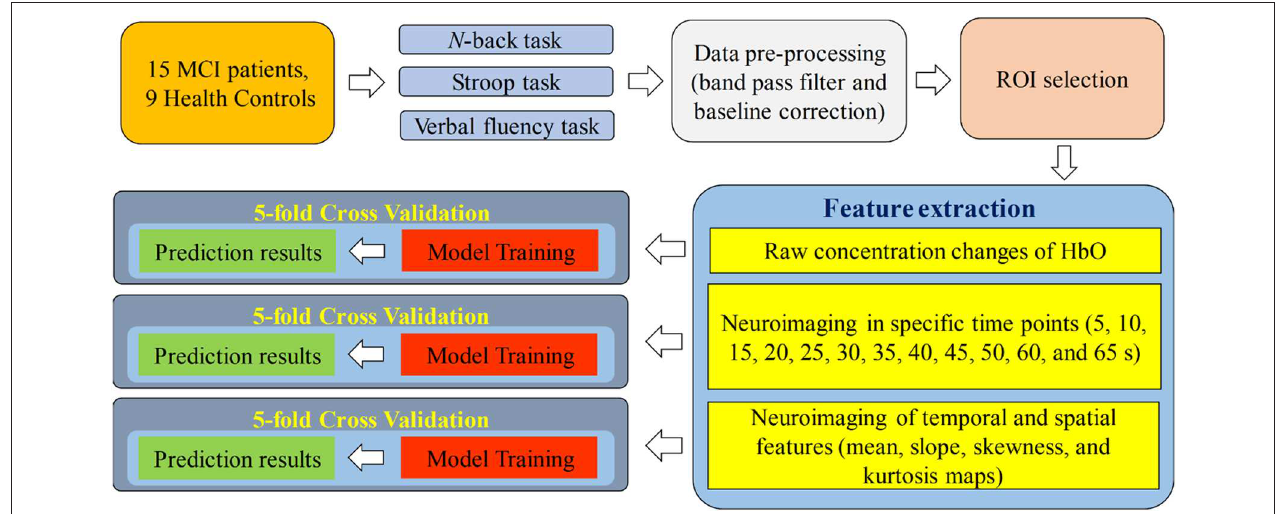
FIGURE 1 | Systematic diagram of the proposed